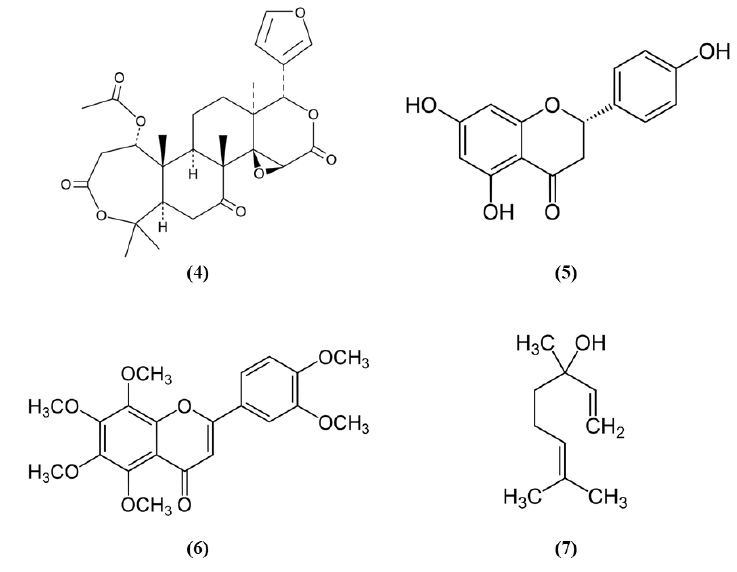
Figure 2. Chemical structure of ( 4 ) nomilin, ( 5 ) naringenin, ( 6 ) nobiletin, and ( 7 ) linalool.